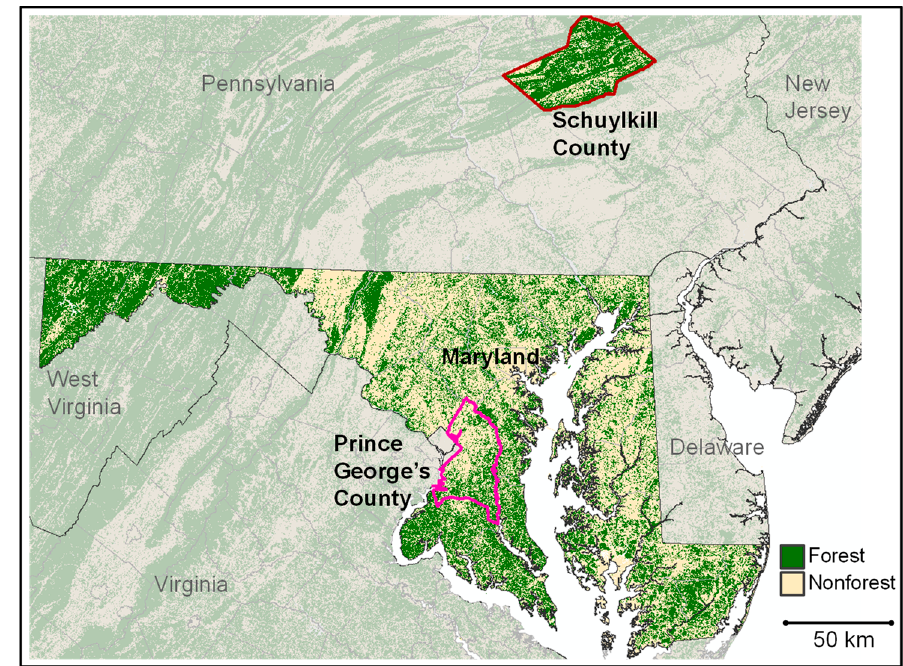
Figure 1. Study areas in Maryland (MD), Prince George’s County (PG), and Schuylkill County (SC), Pennsylvania, USA. Forest/nonforest map from the reclassified 2011 version NLCD (National Land Cover Database) product [9].